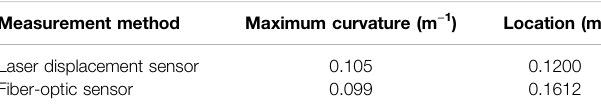
TABLE 5 | Maximum curvature and its location measured by